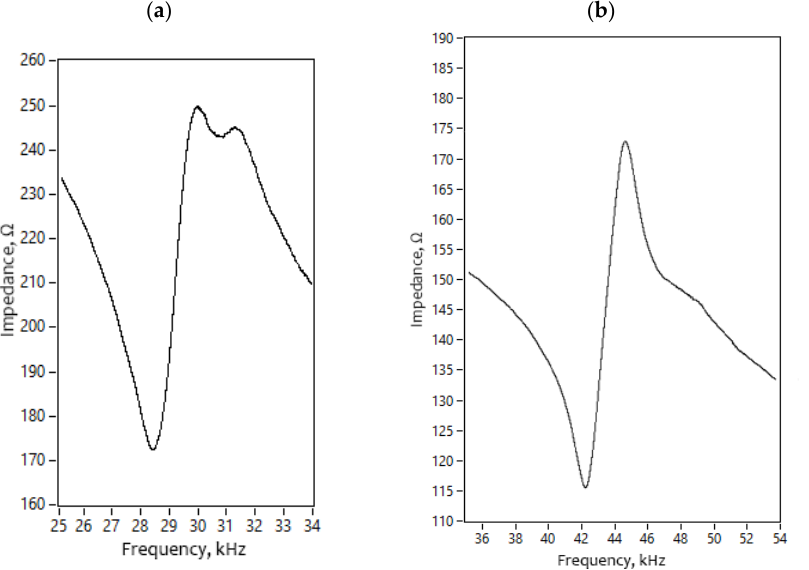
Figure 14. Impedance—frequency characteristics of the robot; ( a )—for planar motion; ( b )—for angular motion.